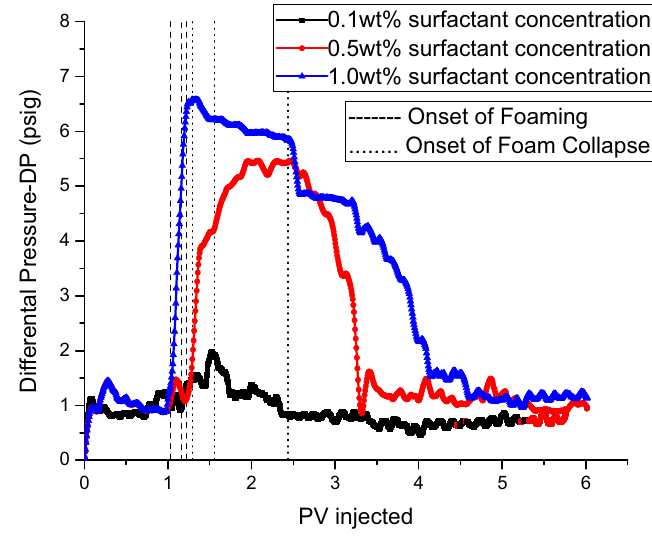
Fig. 6 Determination of the effect of surfactant concentra- tion by sandpack using the unsteady-state surfactant drain- age by gas